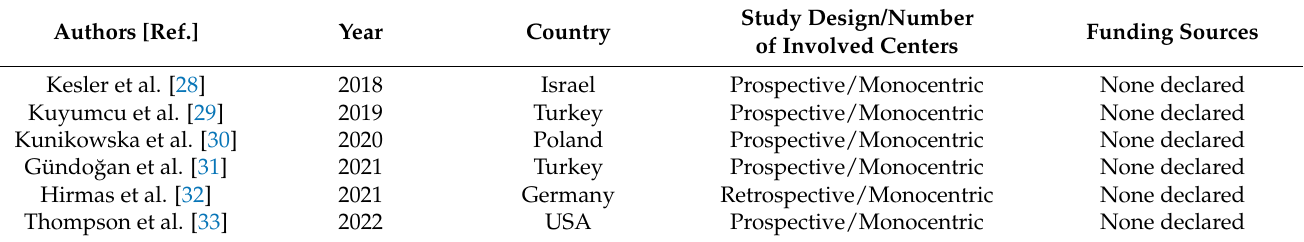
Table 1. General study information.